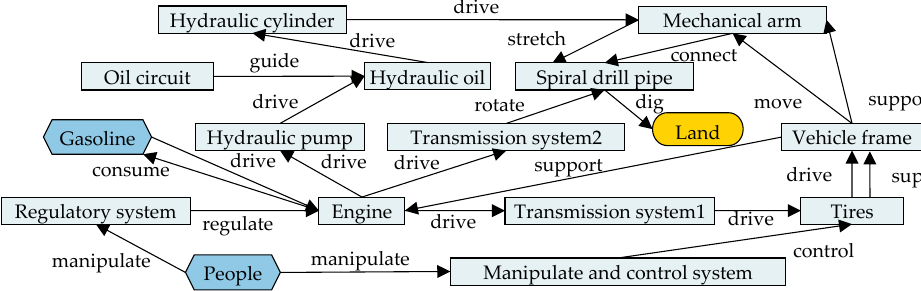
21 of 34 Figure 22. Function-structure mapping of the drill pole tree-planting machine.